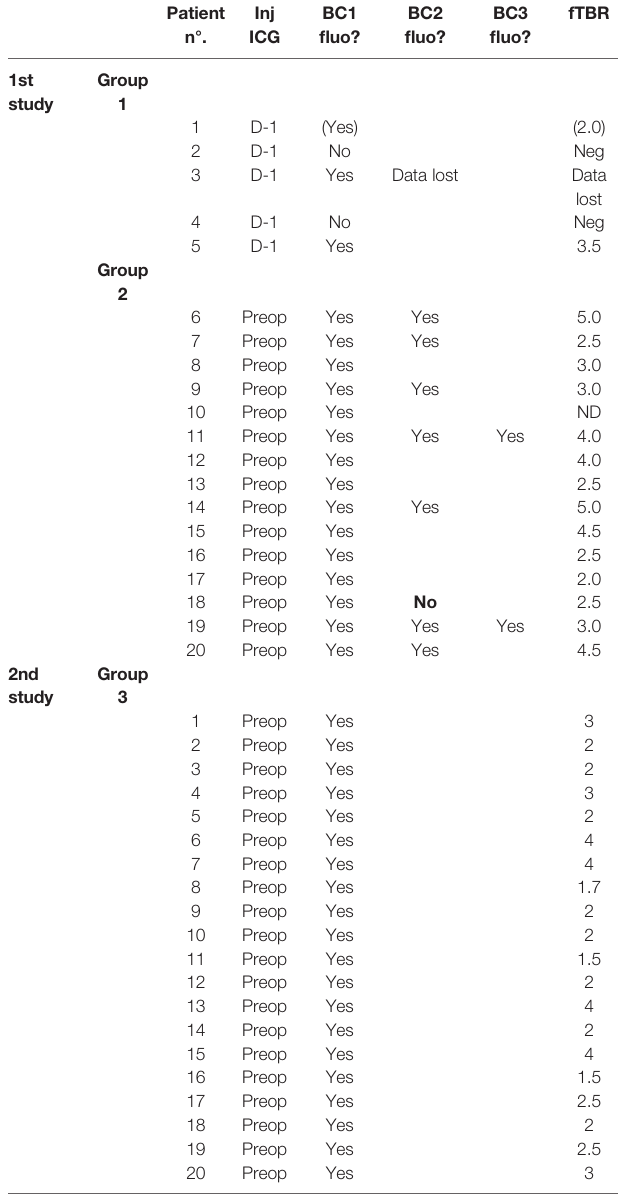
TABLE 1 | Fluorescence or not (and maximum fTBR) of tumors found in patients. TABLE 2 | Number of LNs found by the pathologist in axillary specimens from patients in group